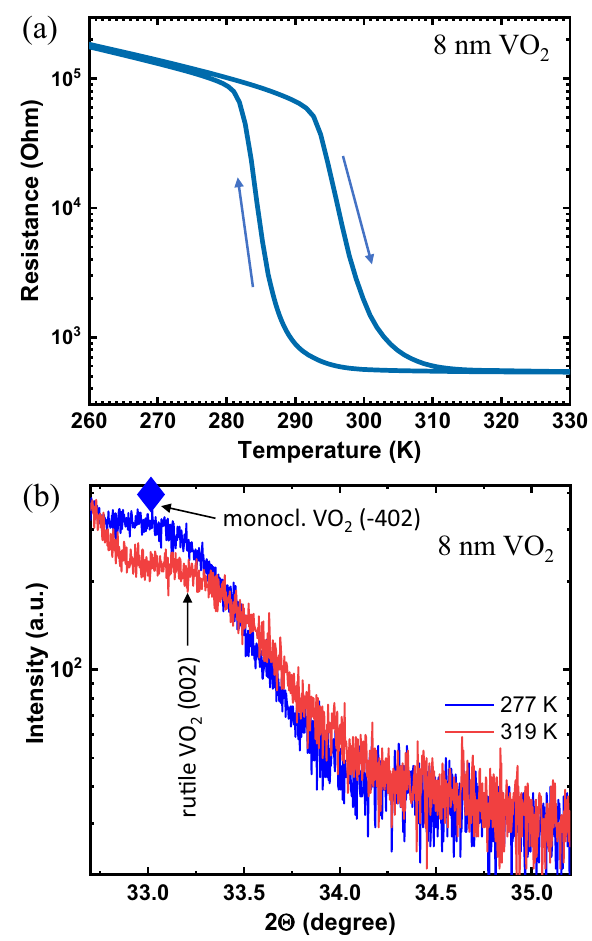
Fig. 3 Transport and structural characterization of an 8 nm thick VO 2 fi lm. a Temperature dependence of resistance of the 8 nm thick VO 2 fi lm on rutile (001) TiO 2 . b XRD patterns obtained from Synchrotron light source of the 8 nm thick VO 2 on (001) TiO 2 below (blue curve) and above (red curve)